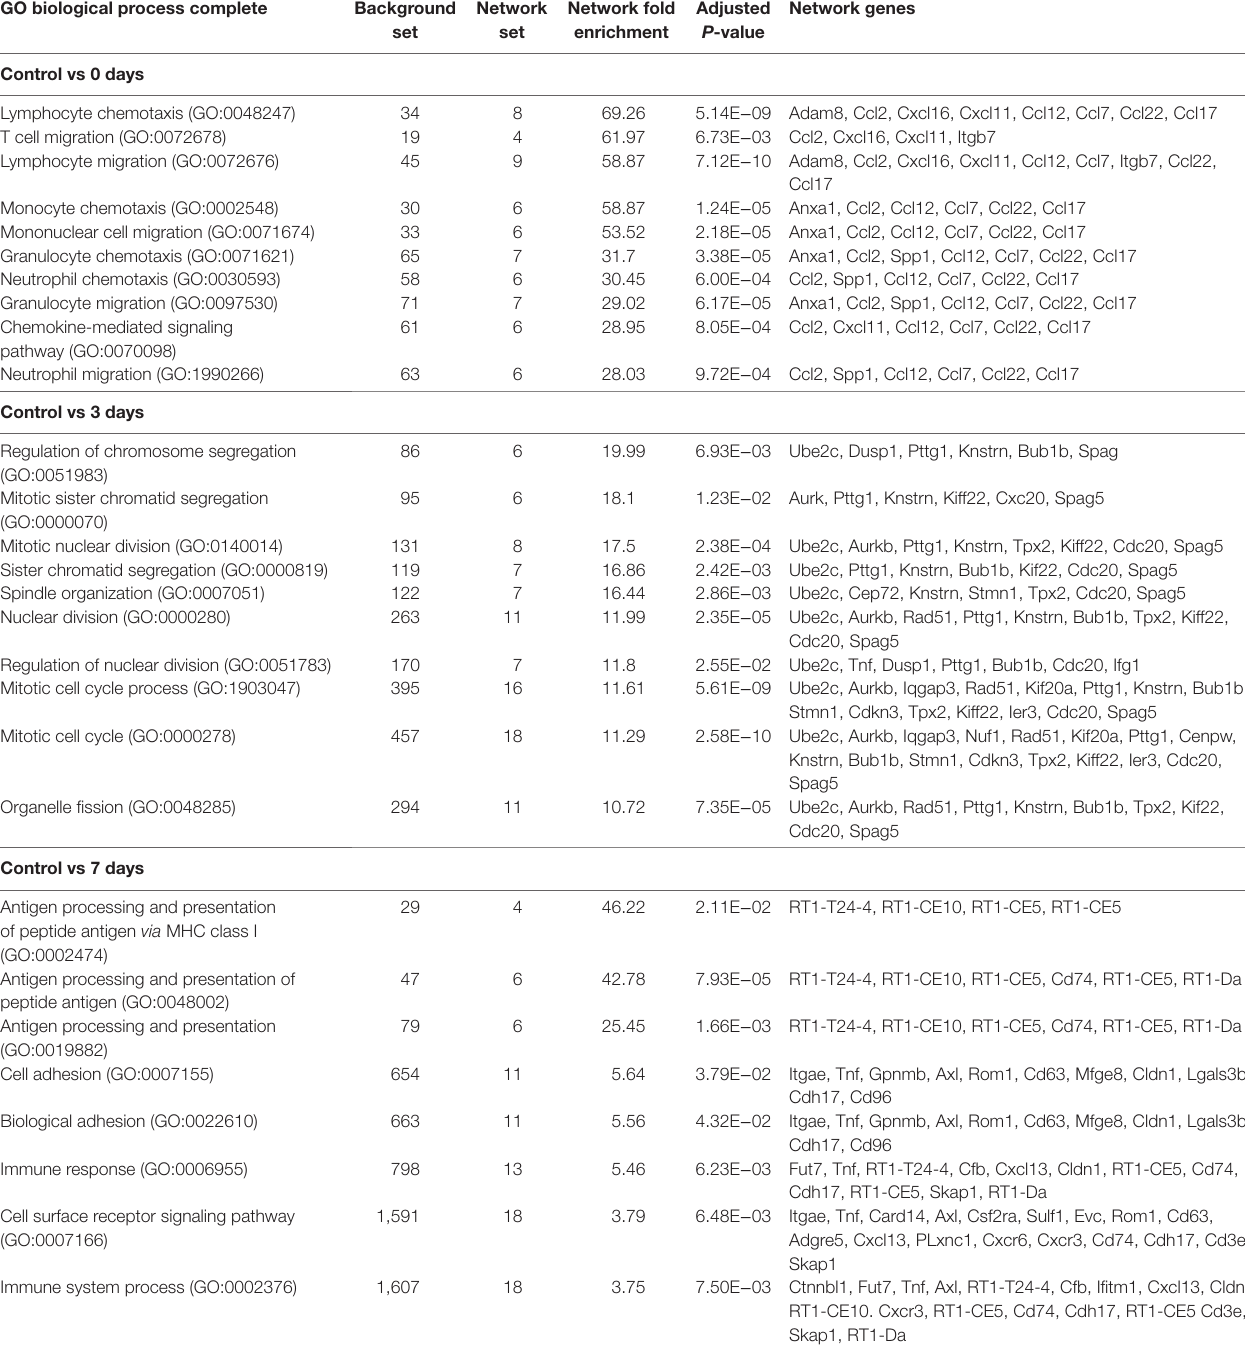
TaBle 1 | Functional overrepresentation of gene ontology (GO):BP terms in panther. gO biological process